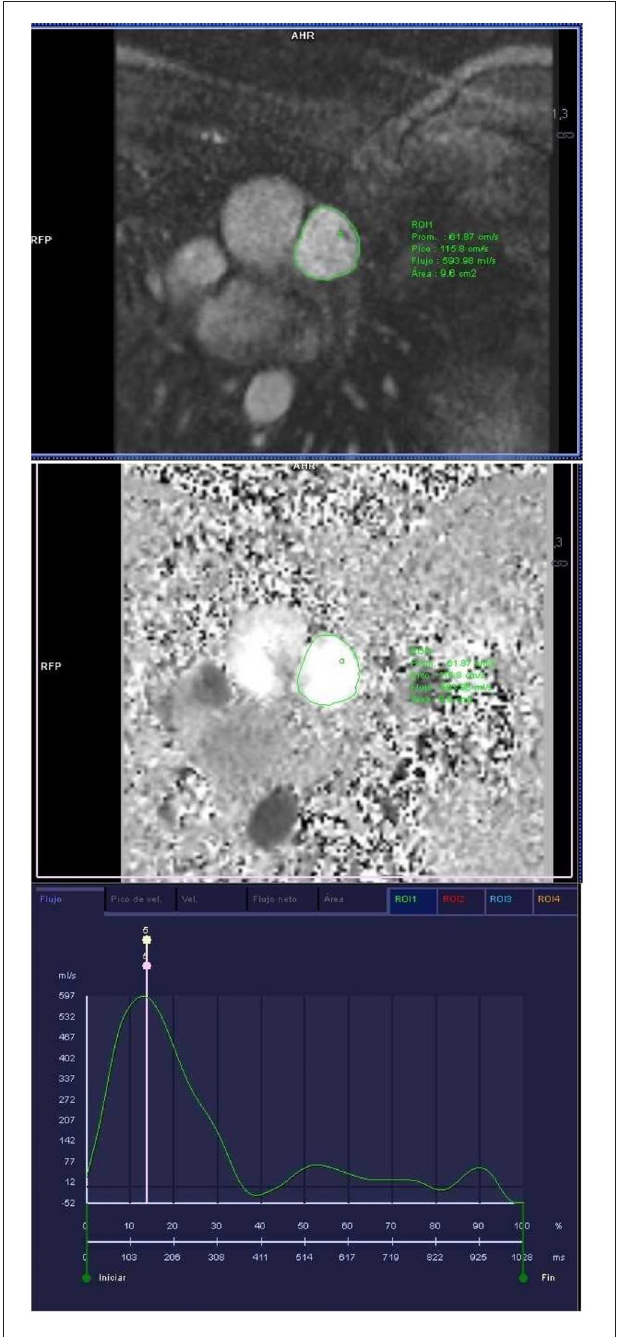
FIGURE 1 | Phase contrast sequence at the level of the main pulmonary artery for the study of pulmonary artery velocities and volumes and subsequent calculation of